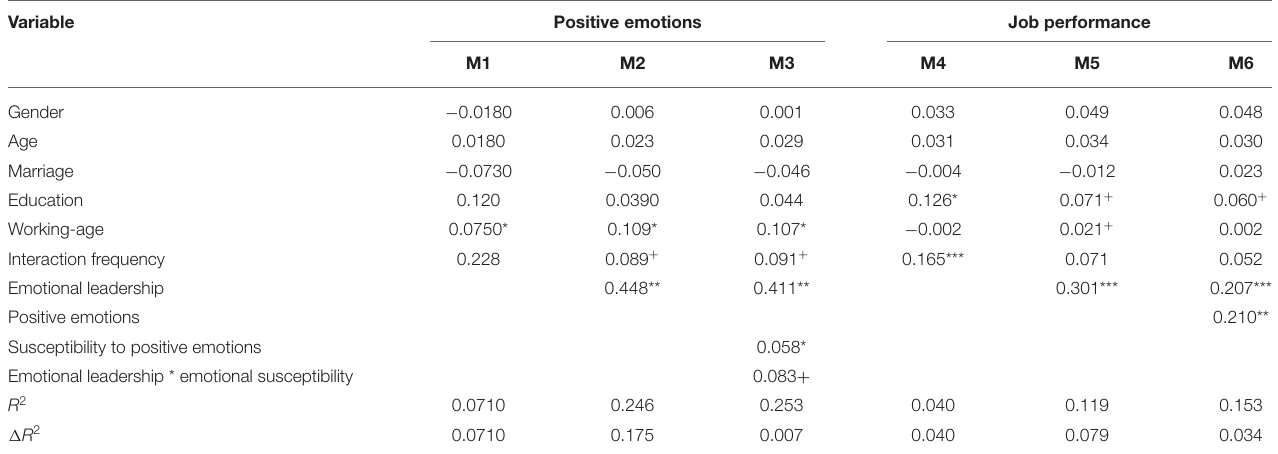
TABLE 2 | Hierarchical regression analysis.